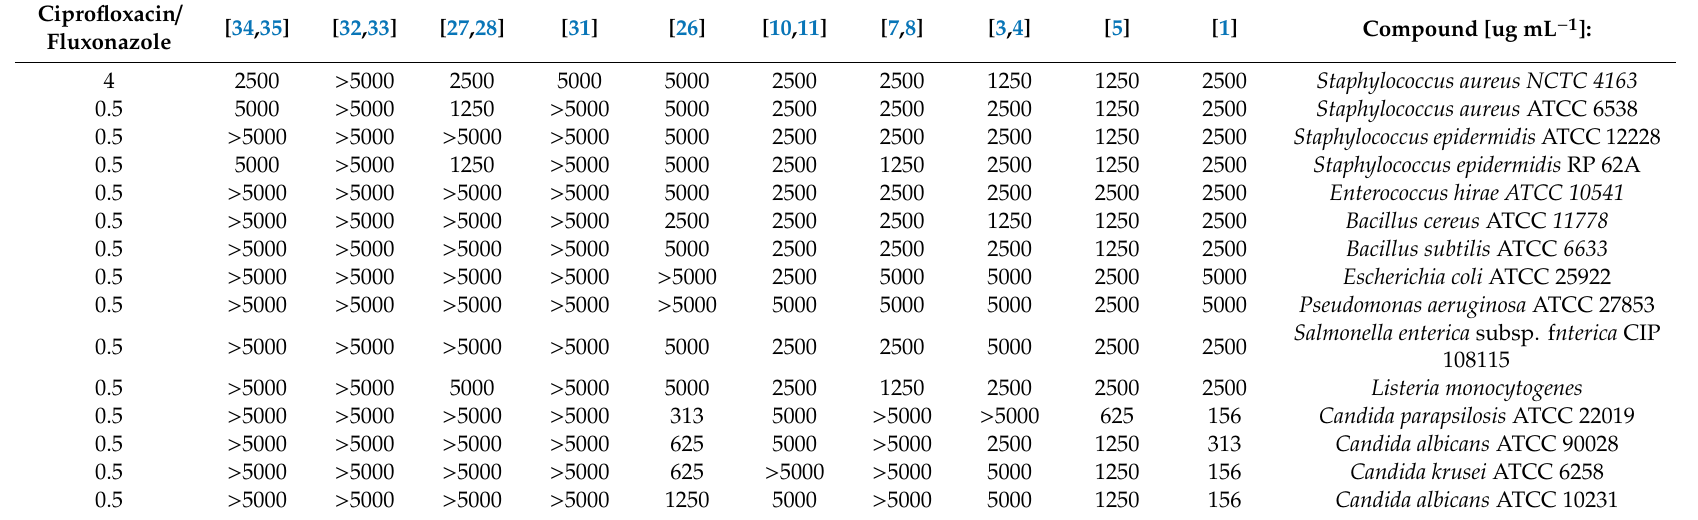
Table 3. Activity of modified and unmodified PHA monomers and their SFAE against standard bacteria and fungi strains – minimal inhibitory concentrations (MIC, µ g mL − 1 ). Ciprofloxacin